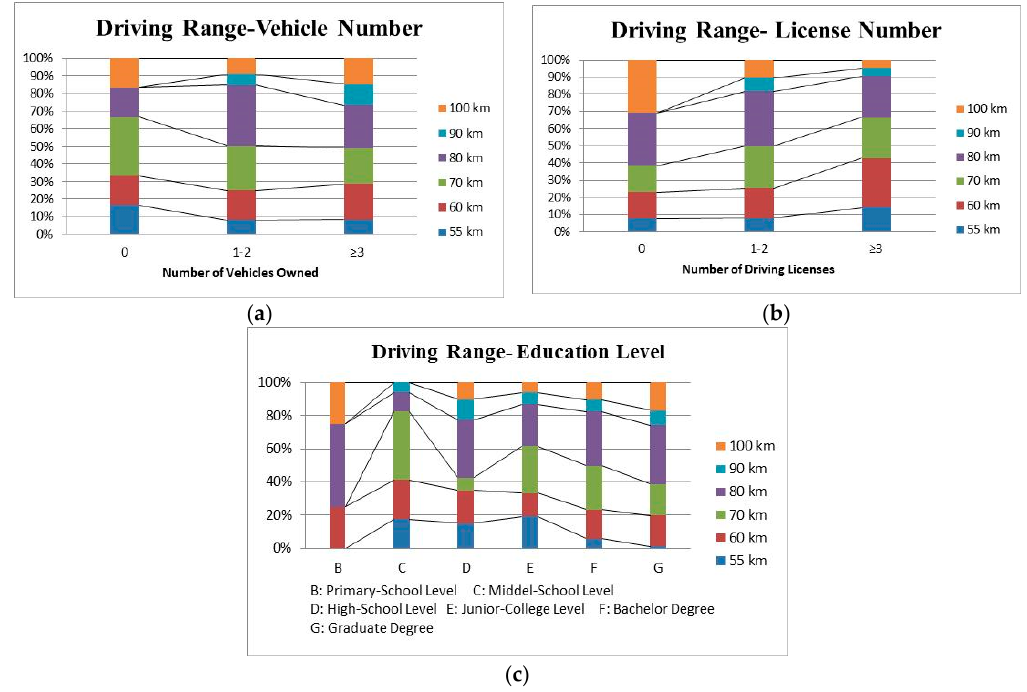
Figure A8. Relationship between the minimum driving range of BEV and significant variables: ( a ) Relationship between driving range and vehicle number; ( b ) Relationship between driving range and license number; ( c ) Relationship between driving range and vehicle number.